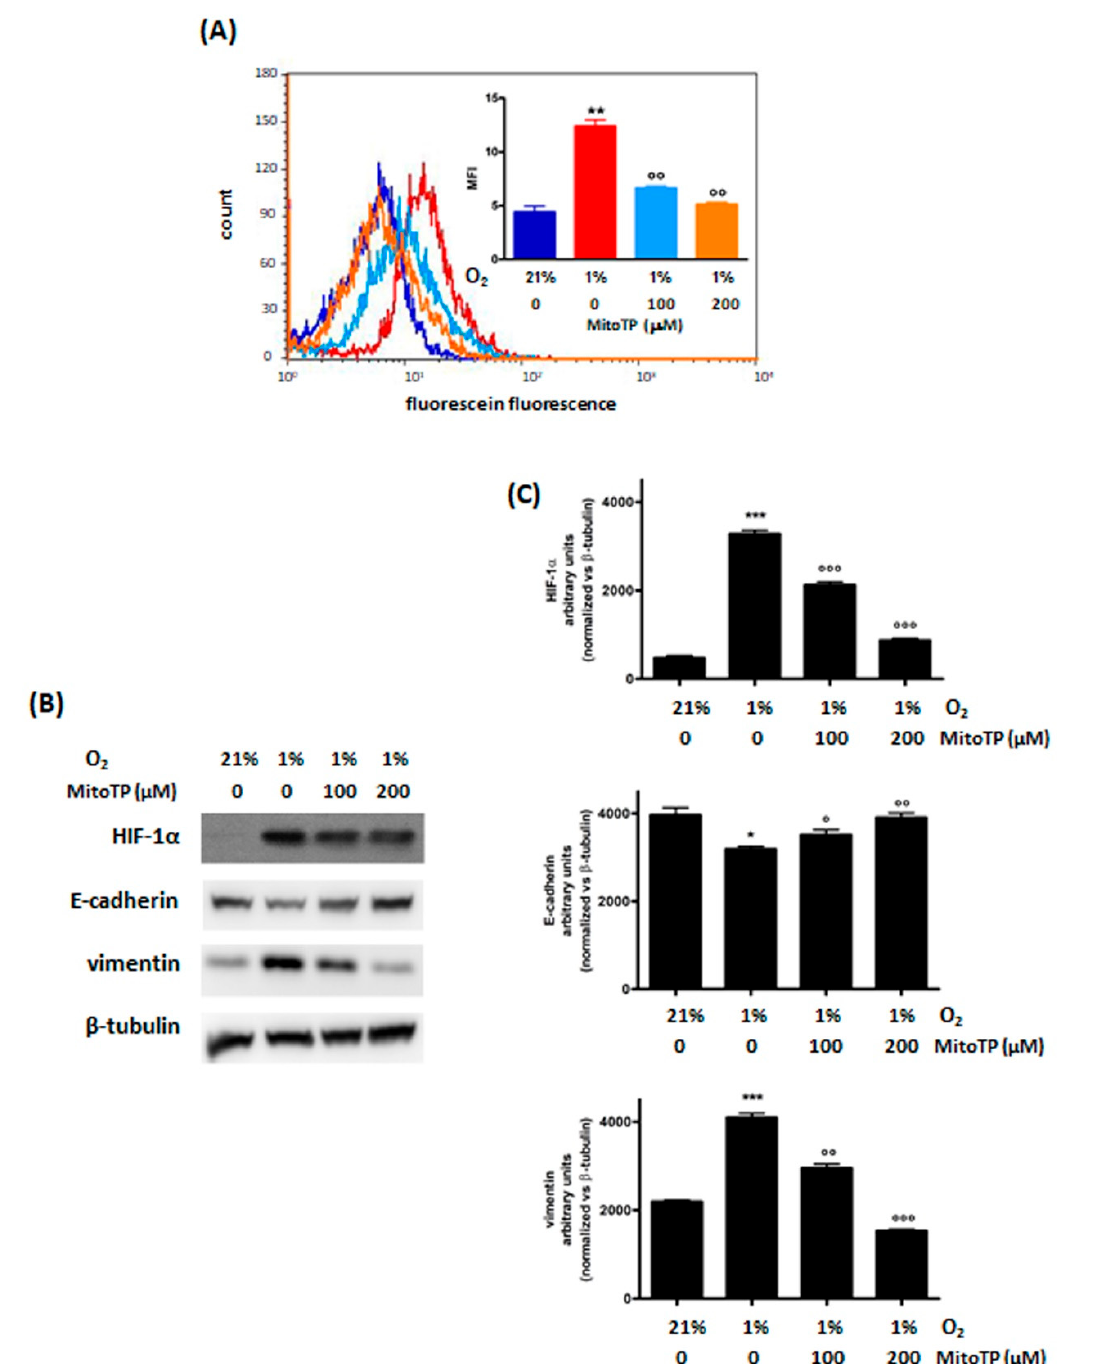
Figure 2. Effects of 48 h treatment with MitoTP (100 and 200 μ M and incubation in normoxic (O 2 21%) or hypoxic (O 2 1%) conditions in MDA − MB468 cells: ROS ( A ) and HIF − 1 α , E − cadherin and vimentin ( B ) levels. The figure shows a representative flow cytometric and Western blot analysis out of 3 independent experiments with similar results. For flow cytometric analysis of ROS levels (blue line: normoxic control; red line: hypoxic control; light blue line: hypoxic MitoTP 100 μ M treated cells; orange line: hypoxic MitoTP 200 μ M treated cells) fluorescence intensity was quantitated based on the Median Fluorescence Intensity (MFI) and results obtained in 3 independent experiments are reported in the graph. Densitometric analysis ( C ) was performed on all experiments (* p < 0.05, ** p < 0.01 and *** p < 0.001 vs. normoxic control; ° p < 0.05, °° p < 0.01, °°° p < 0.001 vs. hypoxic control).